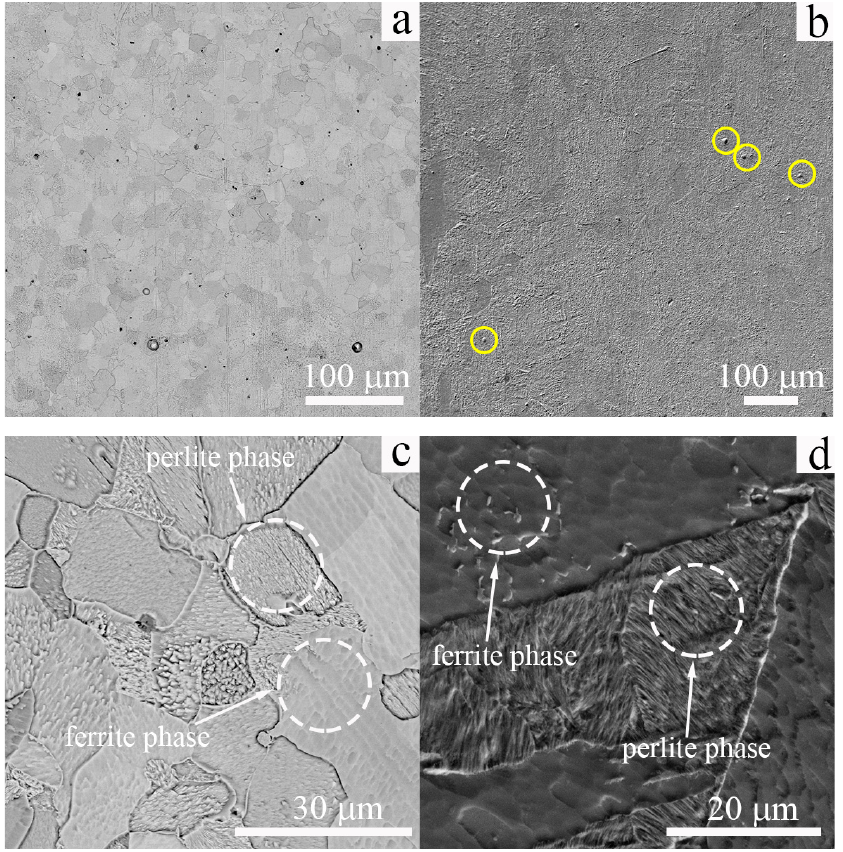
Figure 2. SEM images of the microstructure of the low-carbon steel: ( a , c ) cast and ( b , d ) EBAM. Yellow circles in ( b ) show the coarse carbide particles.